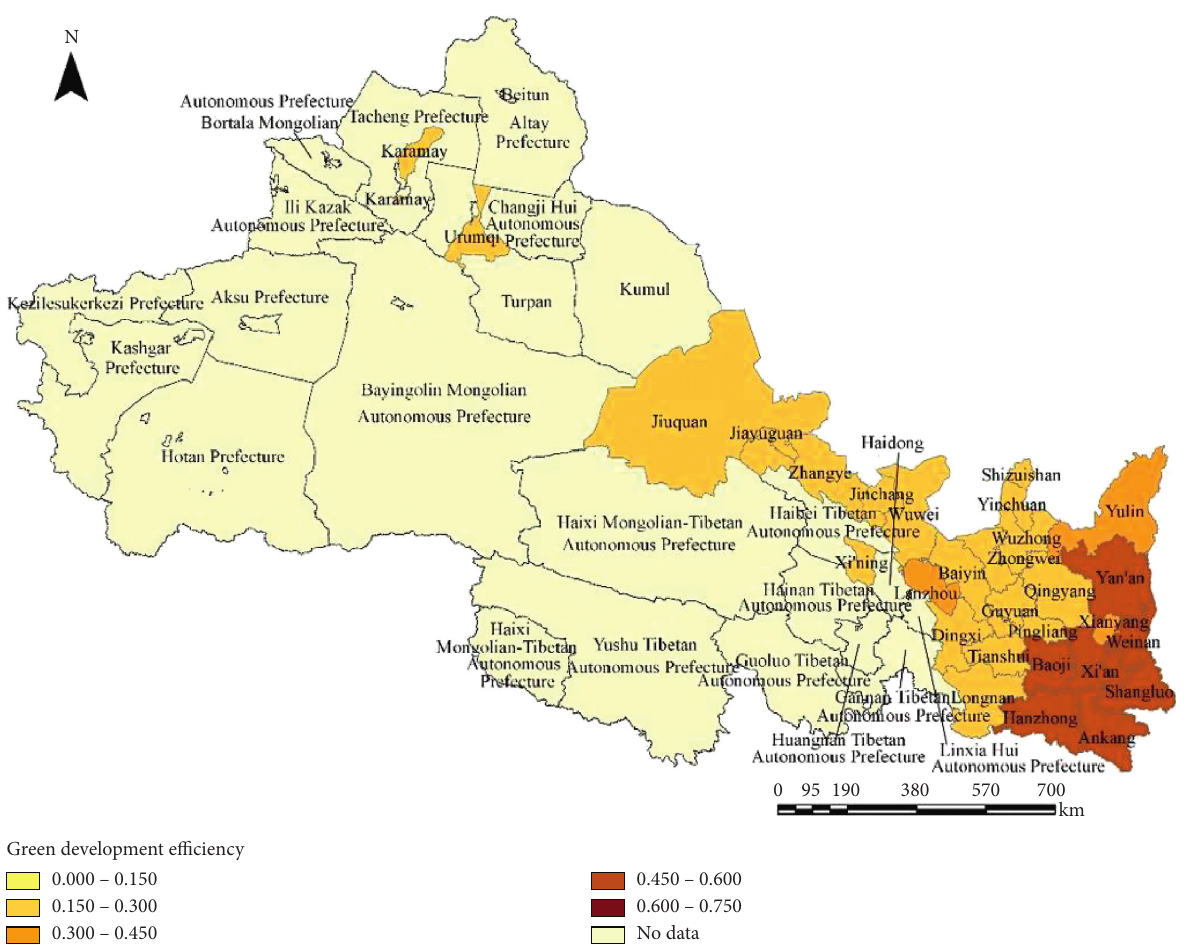
Figure 4: 2007 green development efficiency spatial map of prefecture-level cities in Northwest